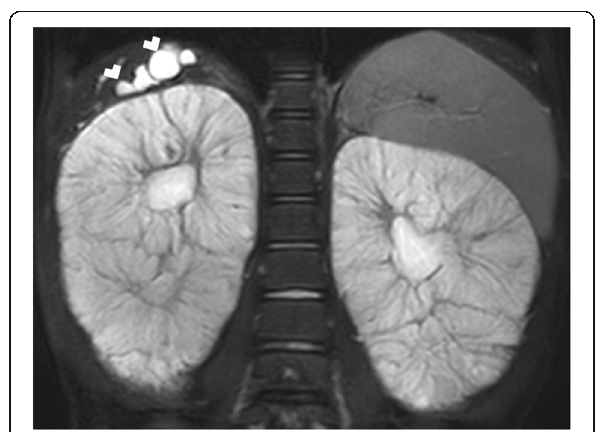
Fig. 17 A 5-year-old male patient with known ARPKD. Coronal plane T2W MR image shows enlarged kidneys with diffusely increased T2 signal. Also note subcentimeter liver cysts (arrowheads)